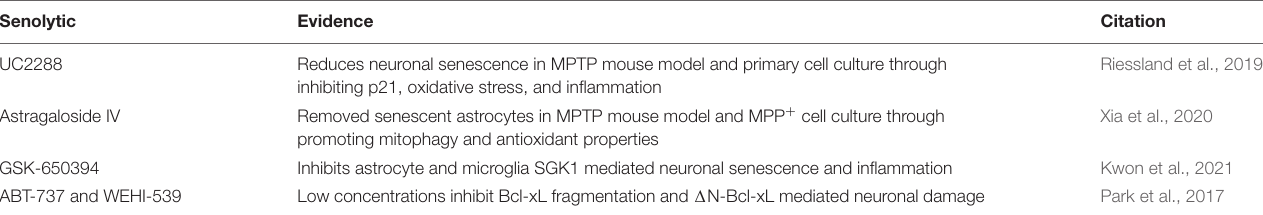
TABLE 1 | Anti-senescent drugs that have therapeutic potential relevant for Parkinson’s